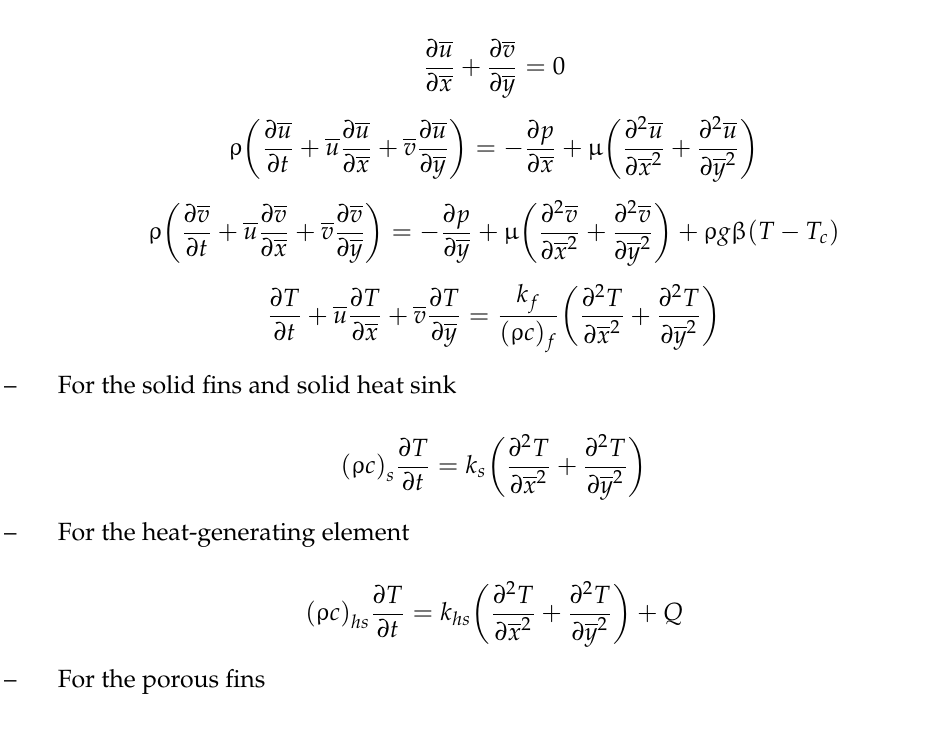
Figure 1. Sketch of the problem with coordinates. The governing equations representing the liquid circulation and energy transport are as follows